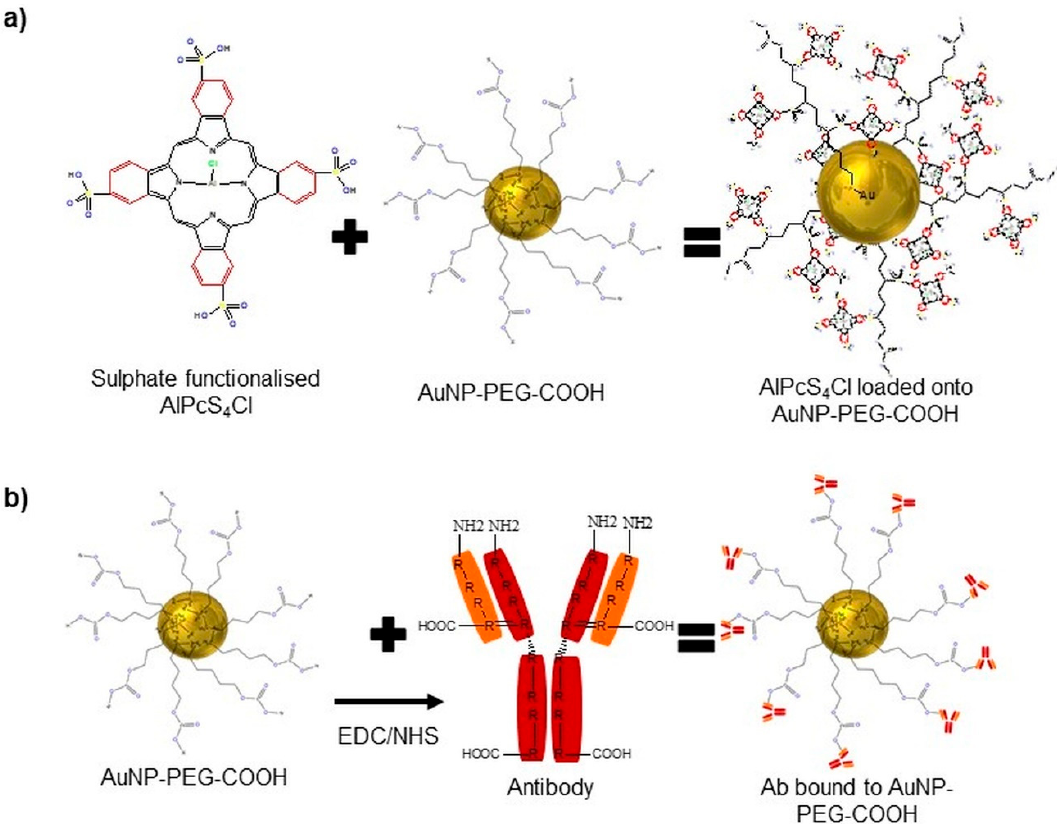
Figure 2. The NBC constructed using a PS (AlPcS 4 C), AuNPs (AuNP-PEG-COOH) and an Ab (Anti-CD133). ( a ) Loading of the sulphate functionalized PS onto the AuNPs via ligand exchange and adsorption. ( b ) Conjugating an Ab onto the AuNPs via EDC-NHS chemistry.